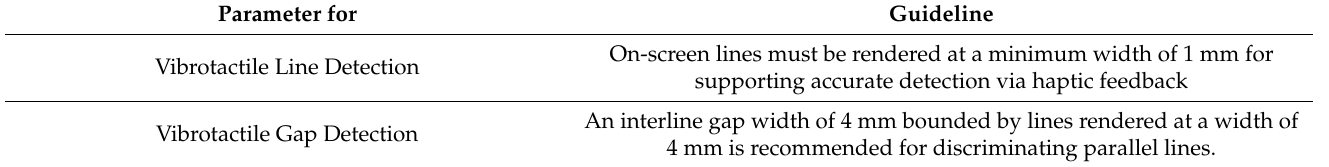
Table 1. Six parameters and guidelines for rendering and schematizing line-based graphical materials on touchscreen devices. Adapted from [30]. Vibrotactile Line Detection Vibrotactile Gap